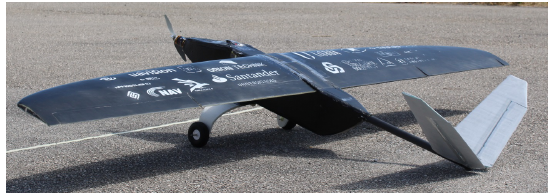
Figure 2. Olissipo Air Team’s 2021